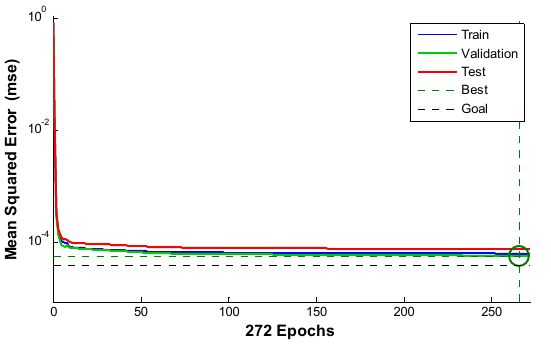
Figure 8. Validation Performance Chart.